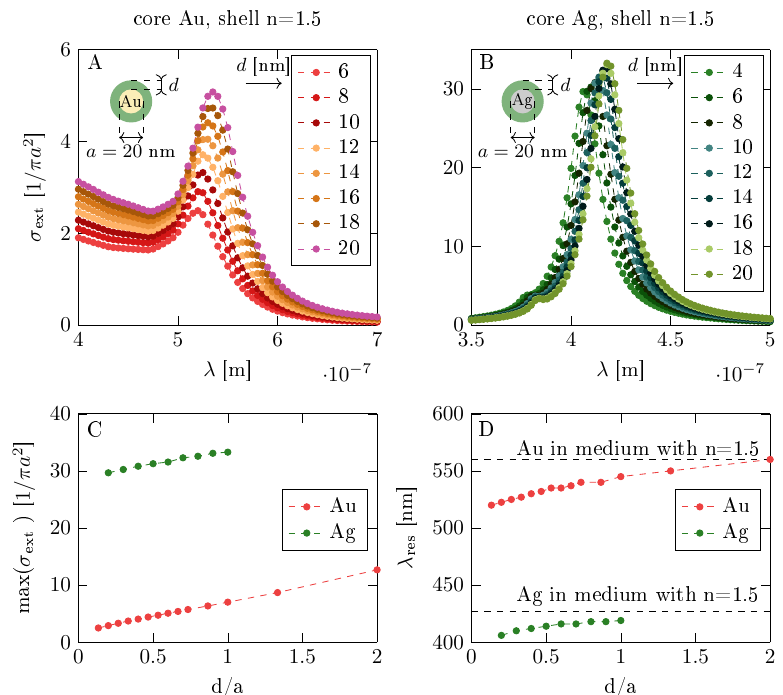
Figure 4. Red shift of the surface plasmon resonance (extinction cross-section spectral dependence) in metallic spherical core with respect to the thickness of the dielectric coating layer, d (for core Au ( A ), Ag ( B )). In the figure, the size dependence is presented for Au and Ag spherical cores with constant radii a = 20 nm with respect to the coating thickness d with the dielectric of permittivity ε = n 2 = 2.25—maximal extinction cross-section ( C ) and central resonance wave length ( D